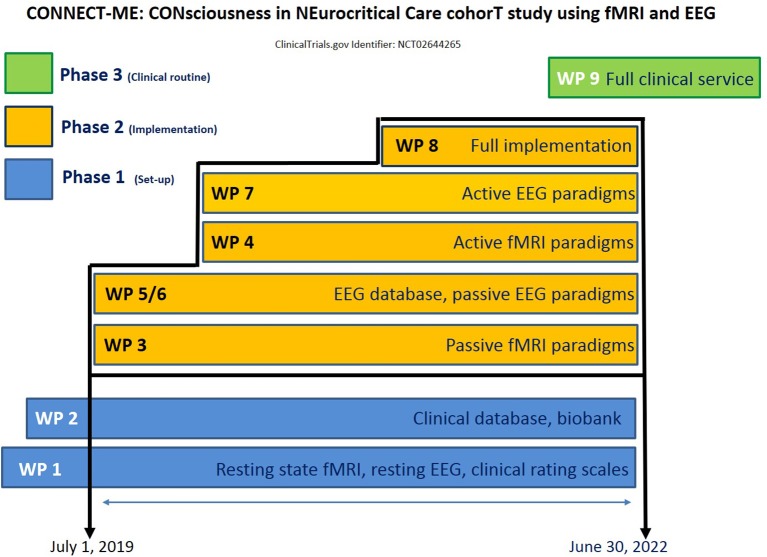
Schematic overview of the work packages and timeline of the project.